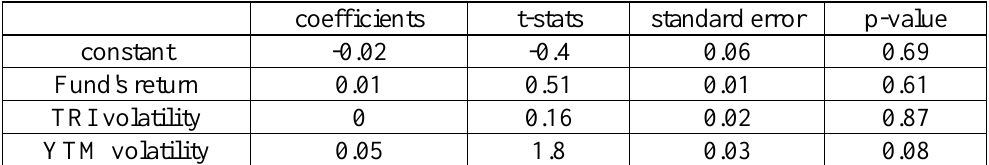
Table 6. Quantile Regression Results for Conditional Value at Risk of System in Late September 2019 When Aseman Yekom Mutual Fund is in stress coefficients